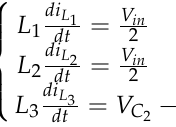
Figure 5. HG-SIQBC—equivalent circuit for Mode I . (The conducting portion of the circuit is shown in Yellow color with the current flow in dotted lines).